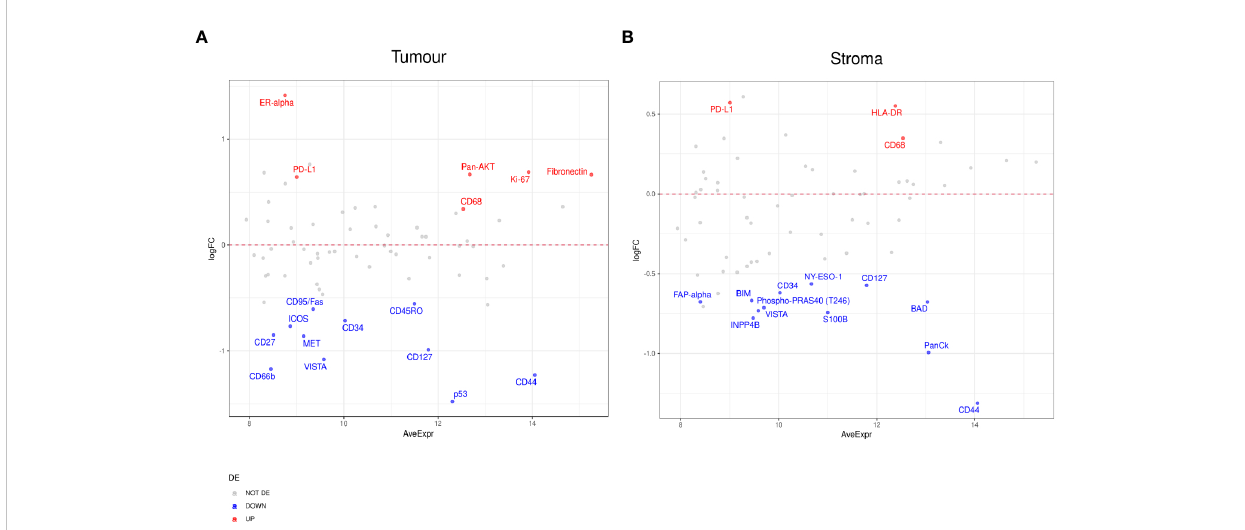
FIGURE 4 Differential protein expression between patients with partial response (PR) (n=5) and progressive disease (PD) (n=8). (A, B) MA plots of Mean Expression (AveExpr) vs fold change (logFC) visualizing expression of protein biomarkers in patients with PR compared to patients with PD for (A) tumor samples or (B) stromal samples. Colors denote not differentially expressed markers (gray), signi fi cantly up- (red) and down-regulated (blue) markers based on false discovery rate (FDR) < 0.05 after multiple comparison